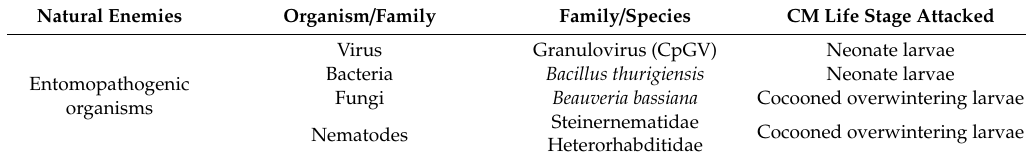
Table 2. Review of codling moth natural enemies and life stage attacked